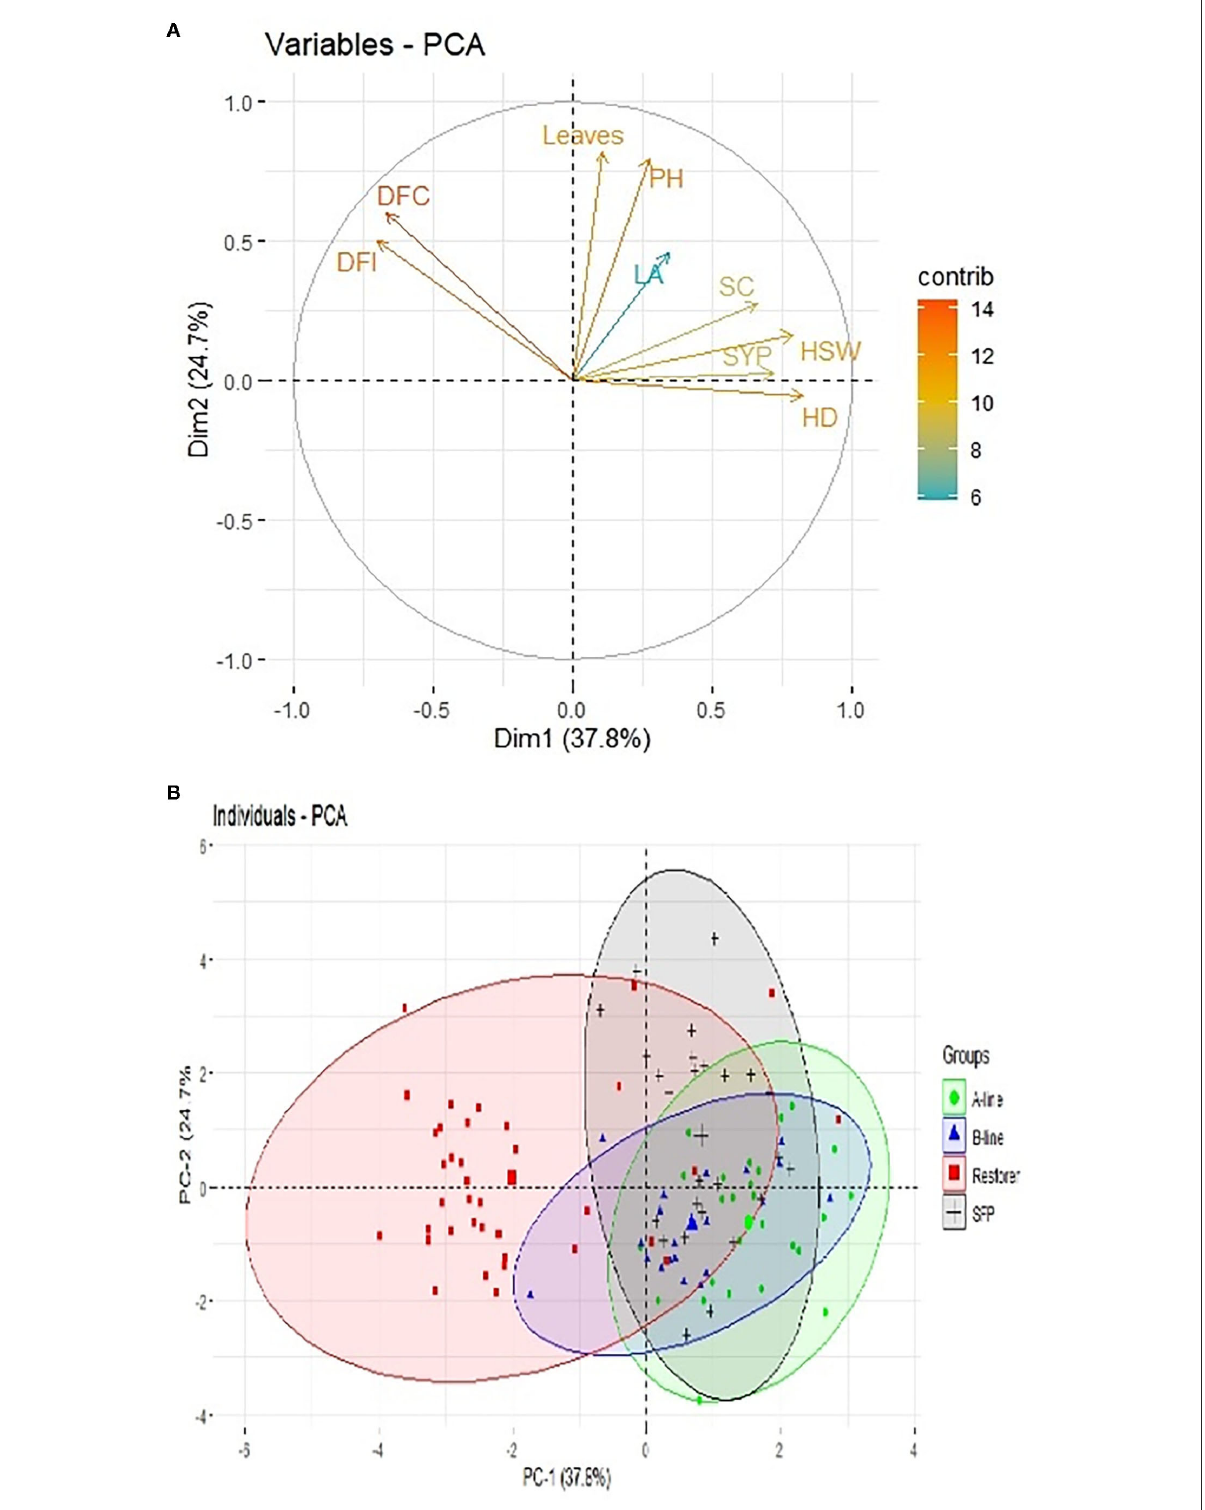
FIGURE3 Scatter plot diagram of nine morphological traits and 109 sunflower genotypes. (A) Variable bi-plot showing contribution of nine traits under study in variability analysis. (B) 109 sunflower genotypes grouping pattern in principal component